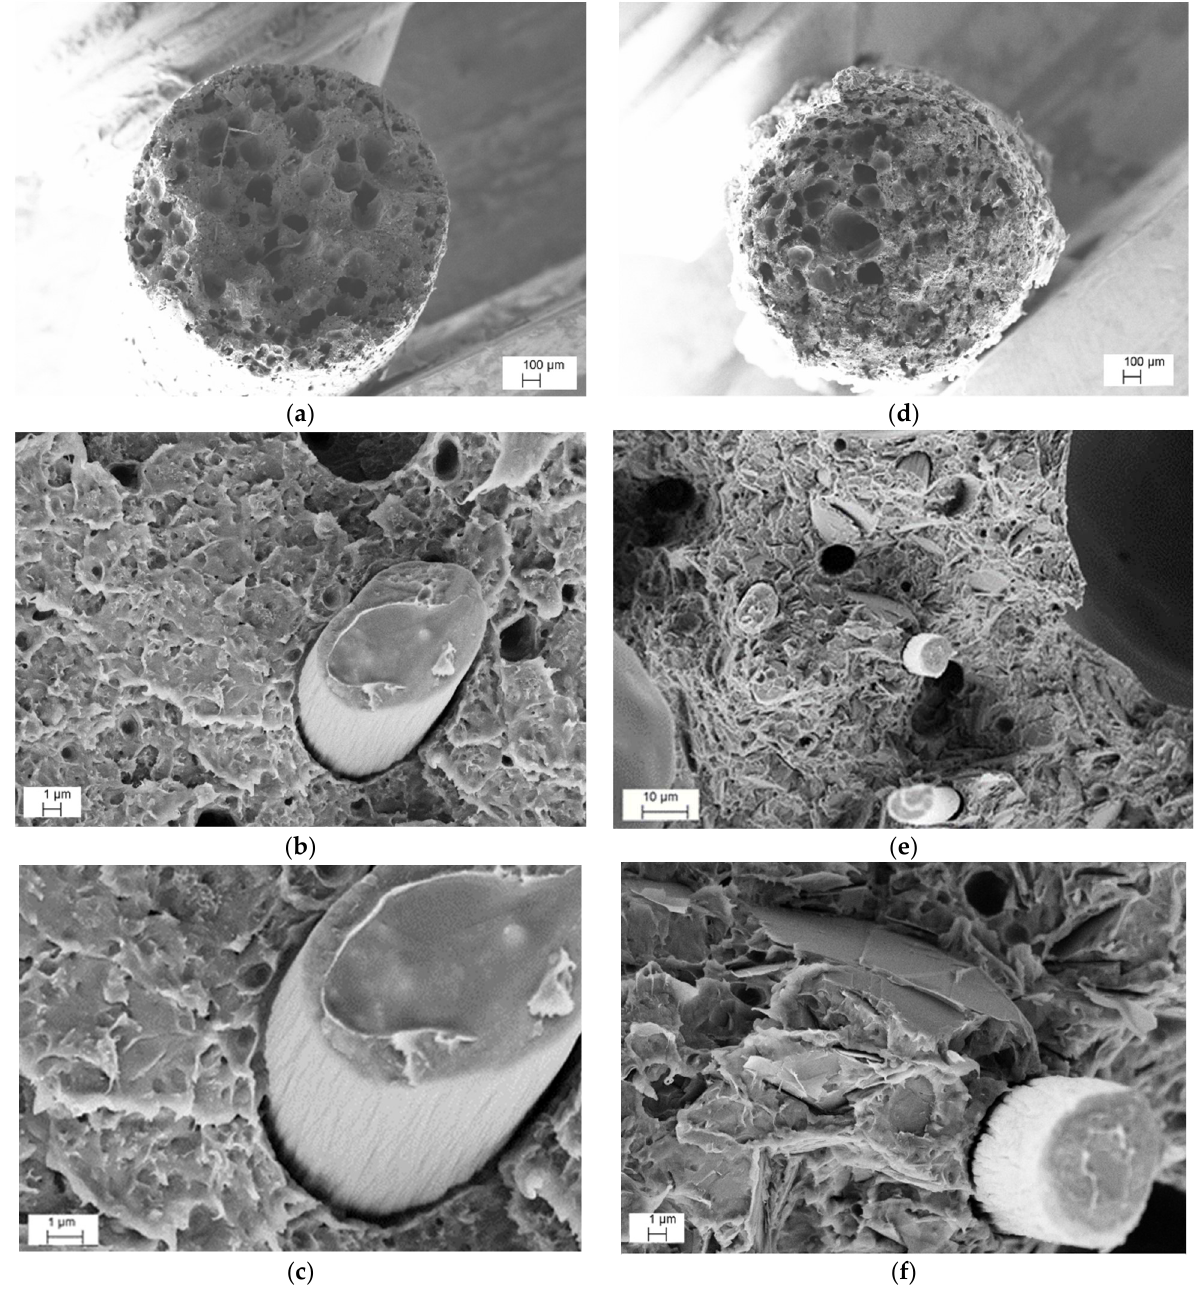
Figure 10. Representative FESEM micrographs at various magnifications of fracture surface of FIL_MCF20-CNT3 ( a – c ) and FIL_MCF20-GNP6 ( d – f ) composite